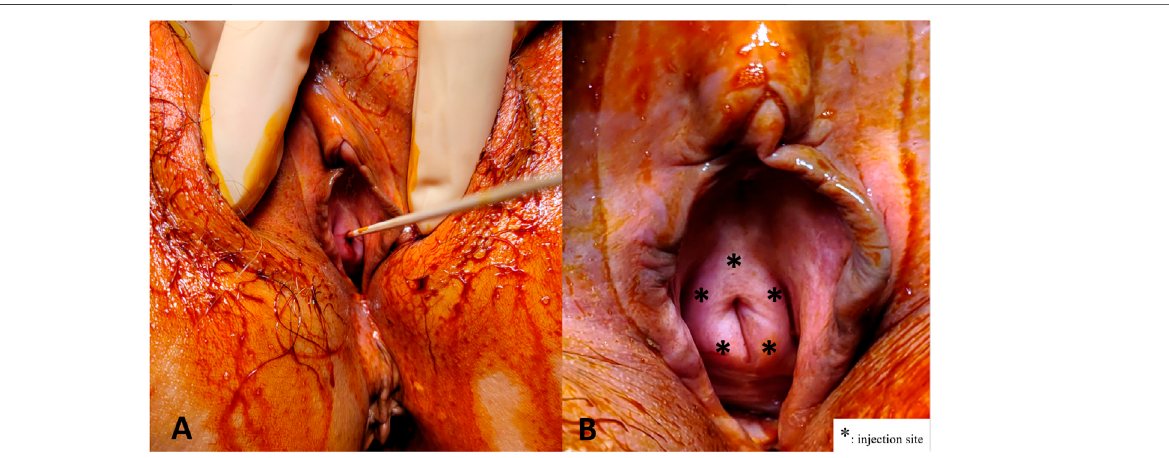
FIGURE1| Platelet-rich plasma(PRP)injectionsfortheurethralsphincter. (A) Asterile6"cotton tippedapplicatorwasinsertedtodeterminetheaxisofurethra. (B) The PRP injections were administered at fi ve sites (*) from the perineum around the urethral meatus in female patients.